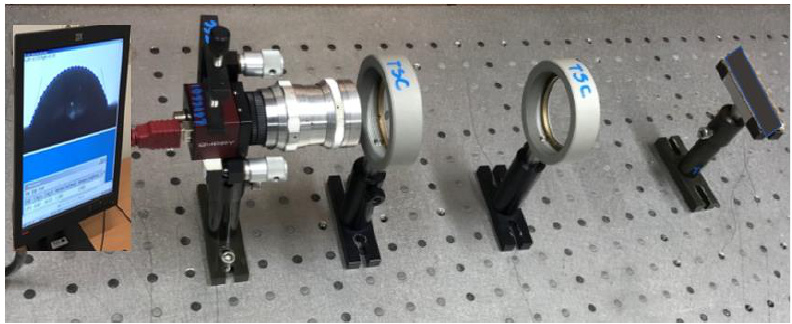
Figure 1. A contact angle measurement setup.